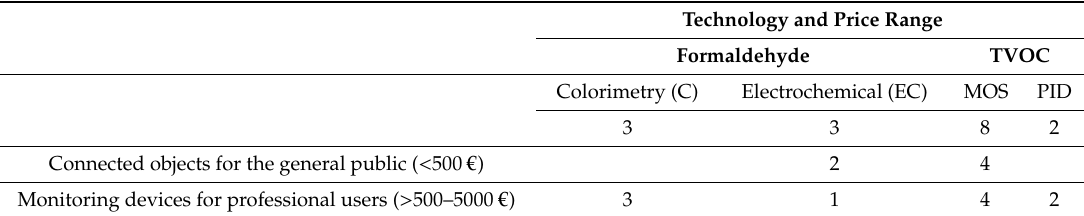
Table 2. Summary of selected sensor technologies and their corresponding price rane. Legend: MOS, metal oxide semi-conductor; PID, photo ionization